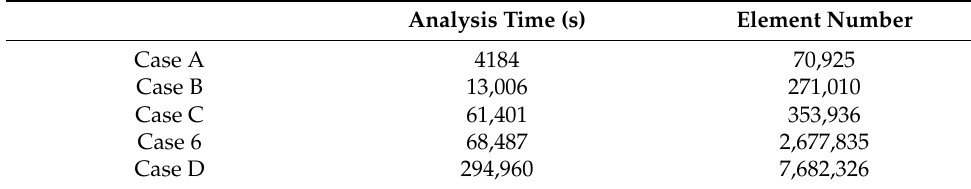
Table 3. The grid models for independence verification.